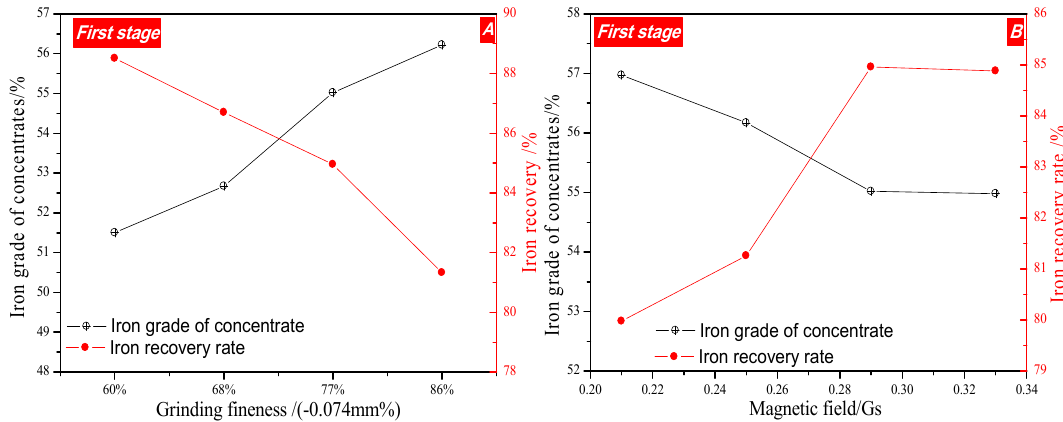
Figure 13. The results of first stage grinding-low intensity magnetic separation process (( A )—Effect of primary grinding fineness on iron recovery at 0.29 T magnetic field; ( B )—Effect of primary intensity of magnetic field on iron recovery under the condition of primary grinding fineness of − 0.074 mm 77%).